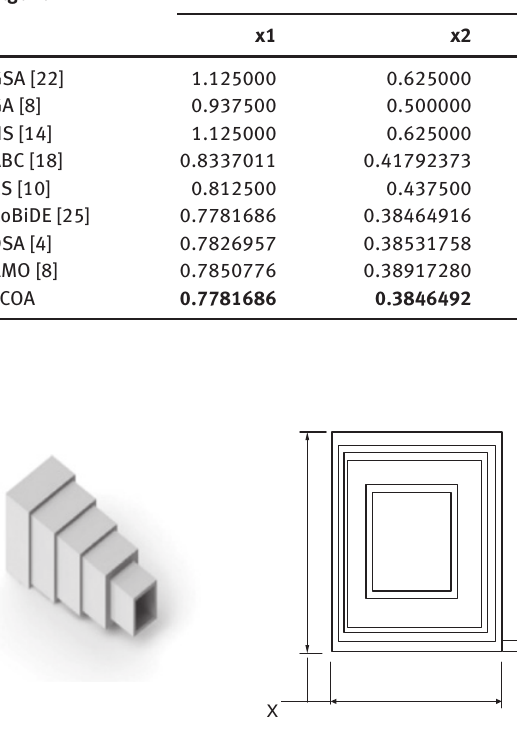
Table 6: Comparison Results for the Pressure Vessel Design Problem. Algorithm